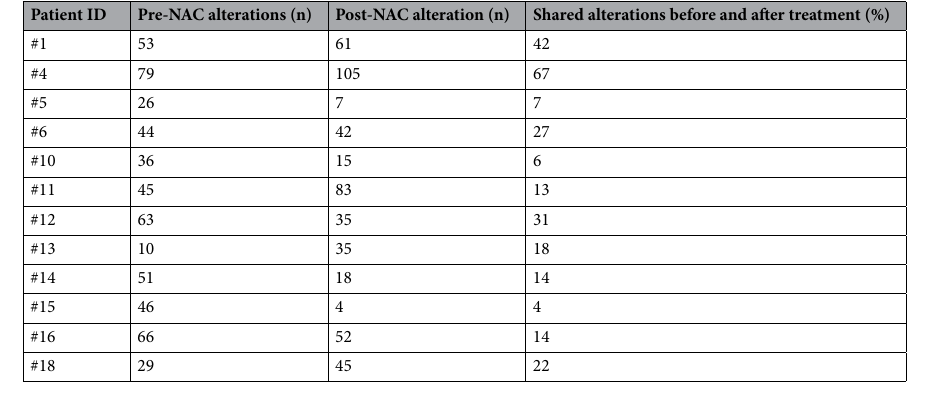
Table 1. Summary of CNAs events in matched pre- and post-NAC